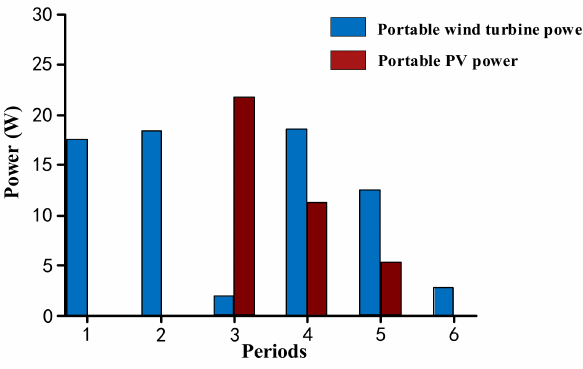
Figure 6. The output power of the portable energy